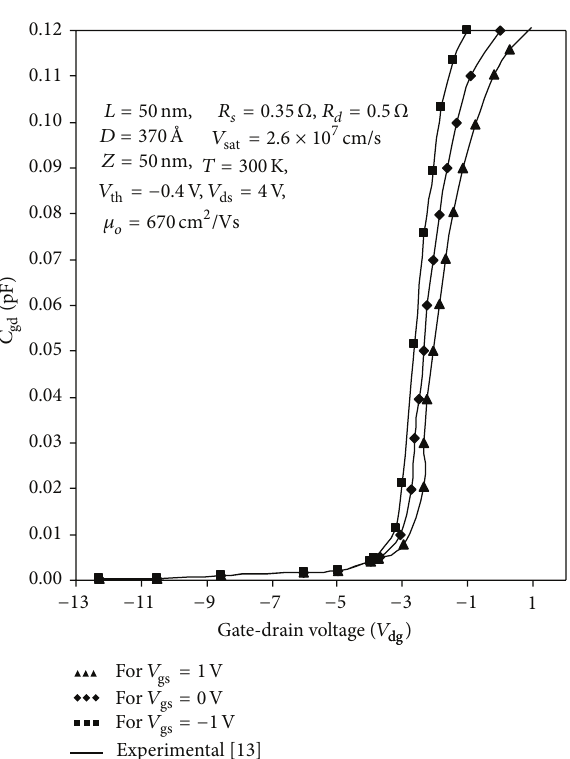
Figure 9: Variation of 𝐶